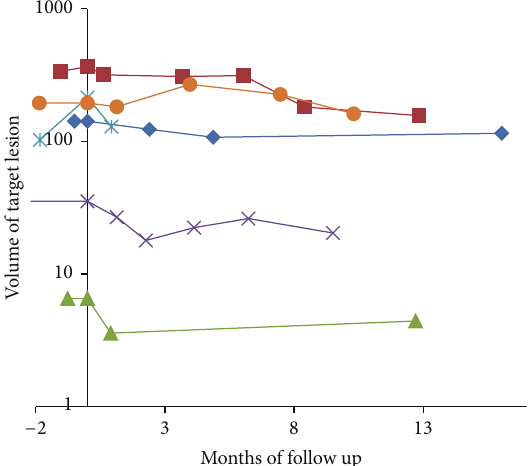
Figure 10: Target lesion volume changes in patients with cholan- giocarcinoma (each curve denotes an individual lesion). All lesions continuously decreased in volume after treatment, initially at a fast rate which decreased over time. In all cases there was a residual lesion left, representing a partial response.